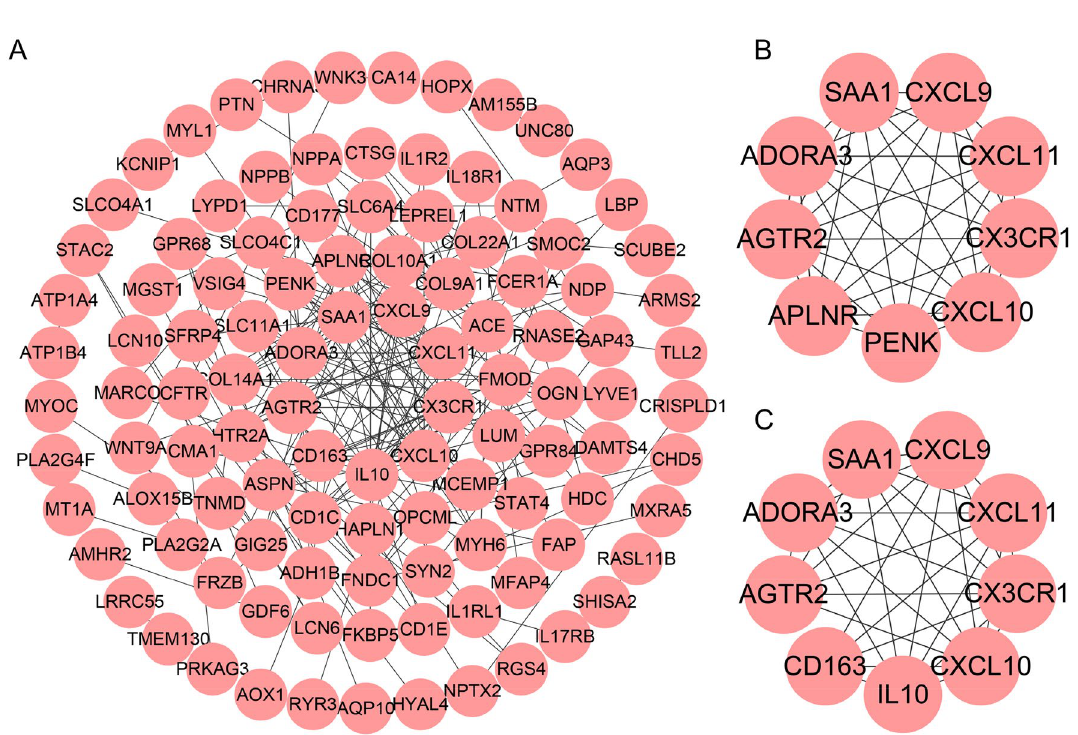
Figure 5. PPI network screening 7 candidate genes. ( A ) A sub-network composed of genes whose degree is greater than 10. ( B ) The key module identified by